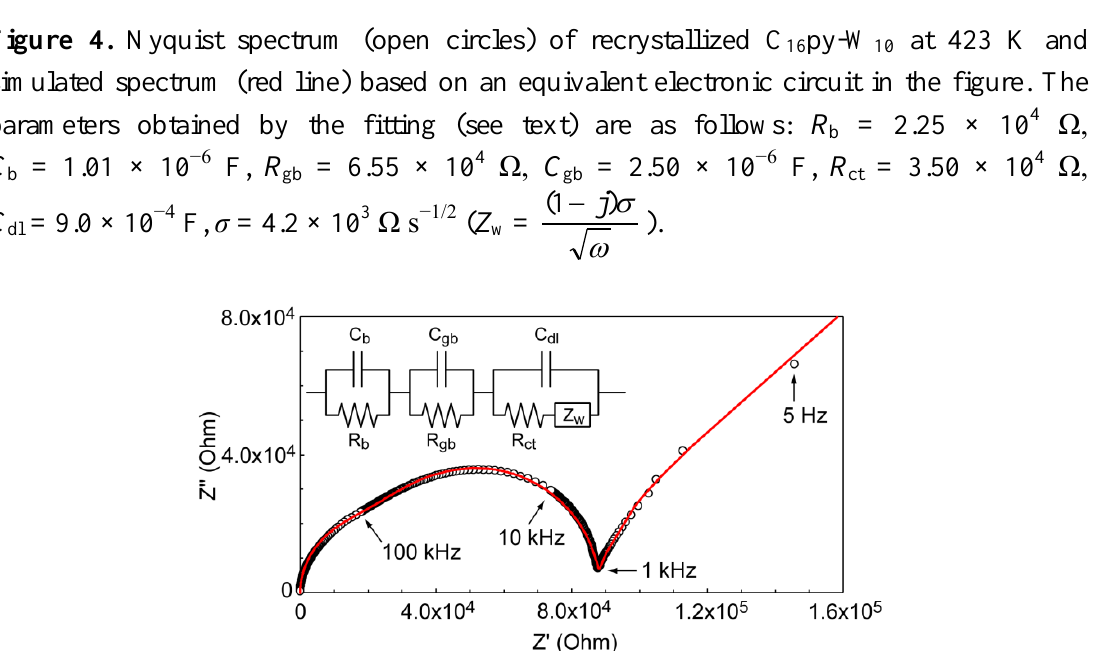
py-W ; ( b ) IR spectra of recrystallized 16 10